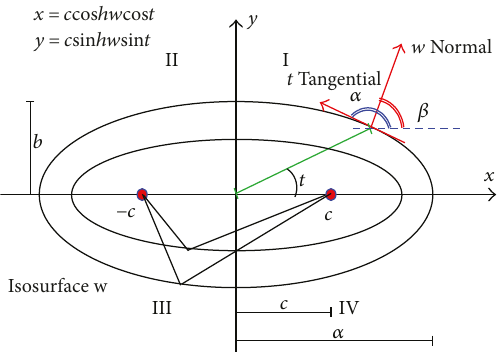
Figure 2: Elliptical cylinder coordinate